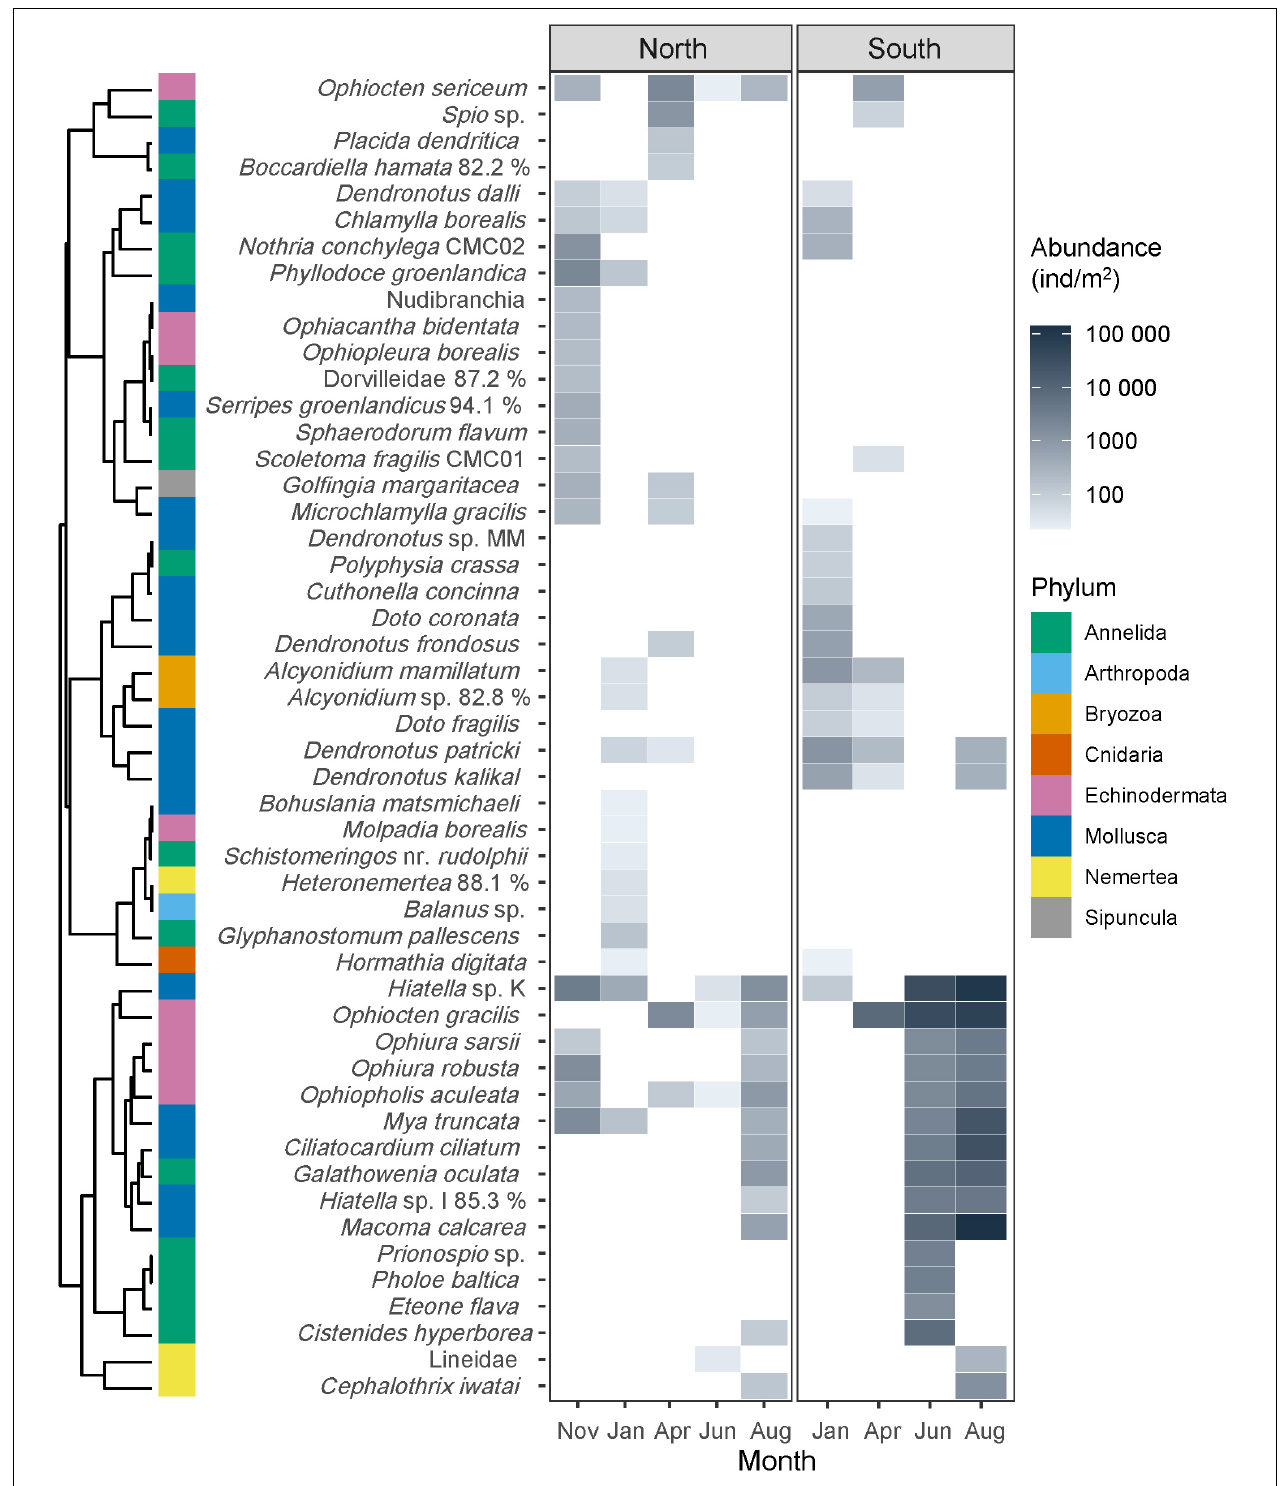
FIGURE 6 | Heatmap of meroplankton species abundance integrated over the entire water column (individuals/m 2 ) north and south of the Polar Front. For readability, only taxa that contributed at least 1% of total abundance of at least one sampling event are included (for all taxa, see Supplementary Table 1 ). Taxa are clustered according to their seasonal and geographical distribution with colors indicating phylum. Note that no samples were taken south of the Polar Front in November 2017.